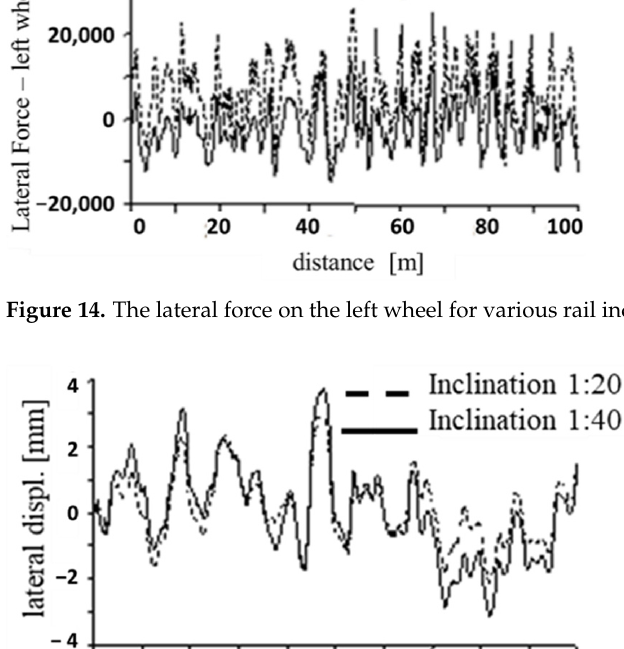
Table 2. The statistical values of the lateral displacement (in m) of the wheelset at various rail in ‐ clinations.